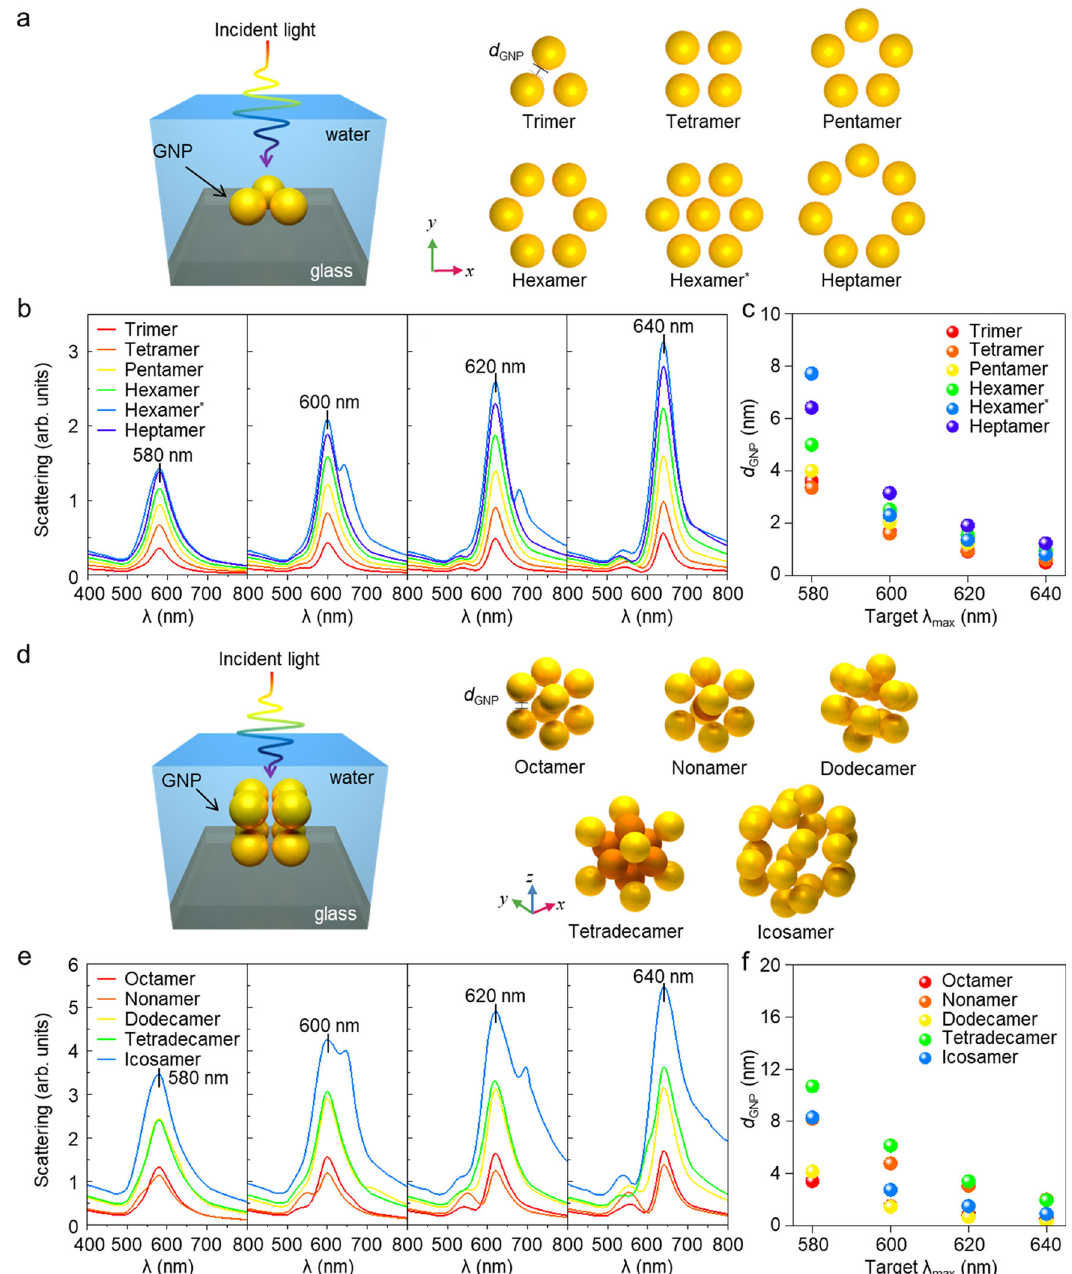
Fig. 3 Computational simulations of the optical properties of arranged gold nanoprobes. a Various arrangements of GNPs in 2D. Domains in simulation and considered arrangements of GNPs, trimer to heptamer. b The scattering cross section of GNPs according to the target wavelength ( λ max ), 580 – 640 nm, left to right. c The expected interparticle distance of each 2D arrangement according to the λ max . d Various arrangements of GNPs in 3D. Domains in simulation and considered arrangements of GNP, octamer to icosamer. e The scattering cross section of GNPs according to the λ max , 580 to 640 nm, left to right. f The expected interparticle distance of each 3D arrangement according to the λ max